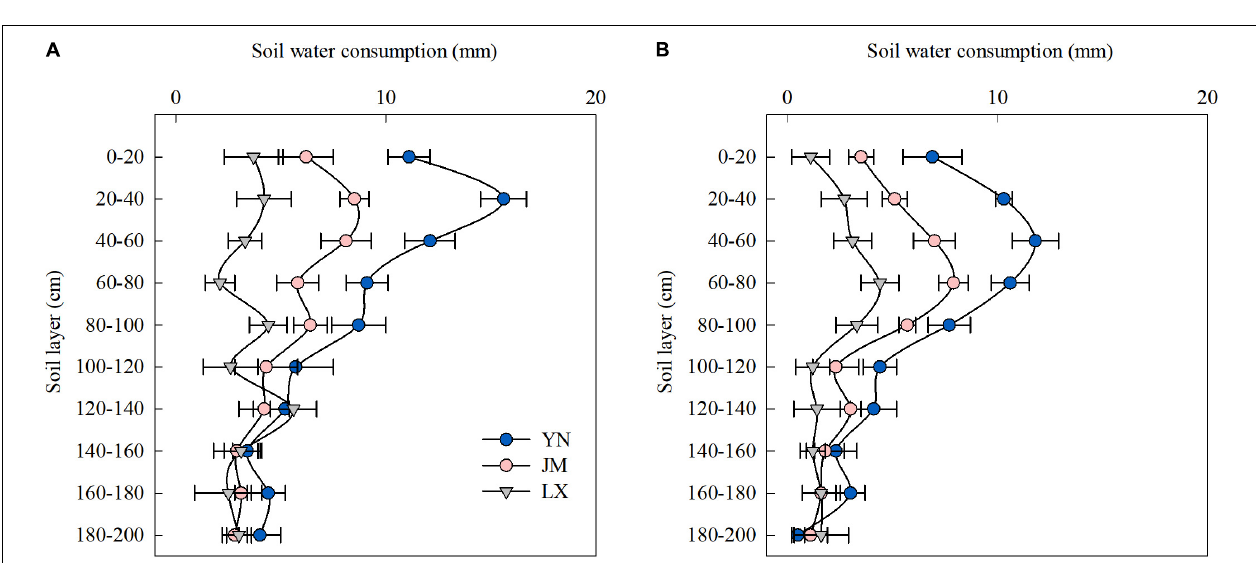
FIGURE 1 | Soil water consumption in different growth periods of wheat varieties in the 2017–2018 (A) and 2018–2019 (B) growing seasons. YN, Yannong 1212; JM, Jimai 22; LX, Liangxing 99; PJ, planting to jointing; JA, jointing to anthesis; AM, anthesis to maturity. The different letters in the figure indicate significant differences (Duncan’s test, p < 0.05). Vertical bars represent the standard deviation of the means.